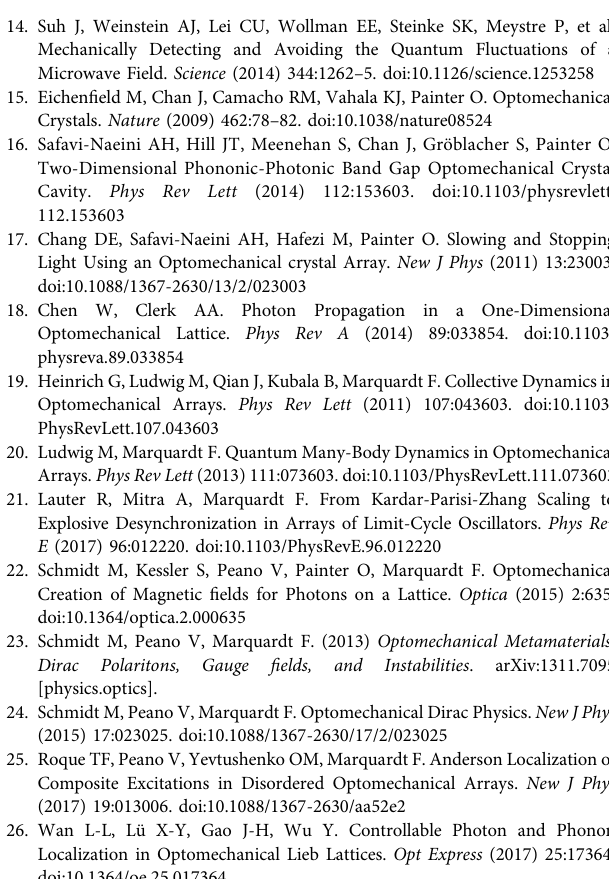
Supplementary Figure S1 | (Color online) Dispersion relations of the generalized SSH model with different hopping amplitude J: (A) J (cid:1) 0; (B) J/v (cid:1) 1; (C) J/v (cid:1) 2; (D) J/v (cid:1) 2.5. (E – H) The paths of the endpoint ofthe vector d(k)corresponding to (A – D) are shown on the dx, dy plane as the wavenumber is sweeped across the Brillouin zone, k (cid:1) 0 → 2 π . The other parameters are z/v (cid:1) 1 and ϕ (cid:1) 0. Supplementary Figure S2 | (Color online) Dispersion relations of the generalized SSH model with different hopping amplitude J: (A) J (cid:1) 0; (B) J/v (cid:1) 1; (C) J/v (cid:1) 2.2; (D) J/v (cid:1) 2.7. (E – H) The paths of the endpoint of the vector d(k) corresponding to (A – D) are shown on the dx, dy plane as the wavenumber is sweeped across the Brillouin zone, k (cid:1) 0 → 2 π . The other parameters are z/v (cid:1) 1.2 and ϕ (cid:1) 0. Supplementary Figure S3 | (Color online) Dispersion relations of the generalized SSHmodelforhoppingamplitude J/v (cid:1) 1.2withdifferentphase: (A) ϕ (cid:1) 0; (B) ϕ (cid:1) ϕ c ≈ 0.12; (C) ϕ (cid:1) 0.3. (D – F) Thepathsoftheendpointofthevectord(k)corresponding to (A – C) are shown on the dx, dy plane as the wavenumber is sweeped across the Brillouin zone, k (cid:1) 0 → 2 π . The other parameter is z/v (cid:1)